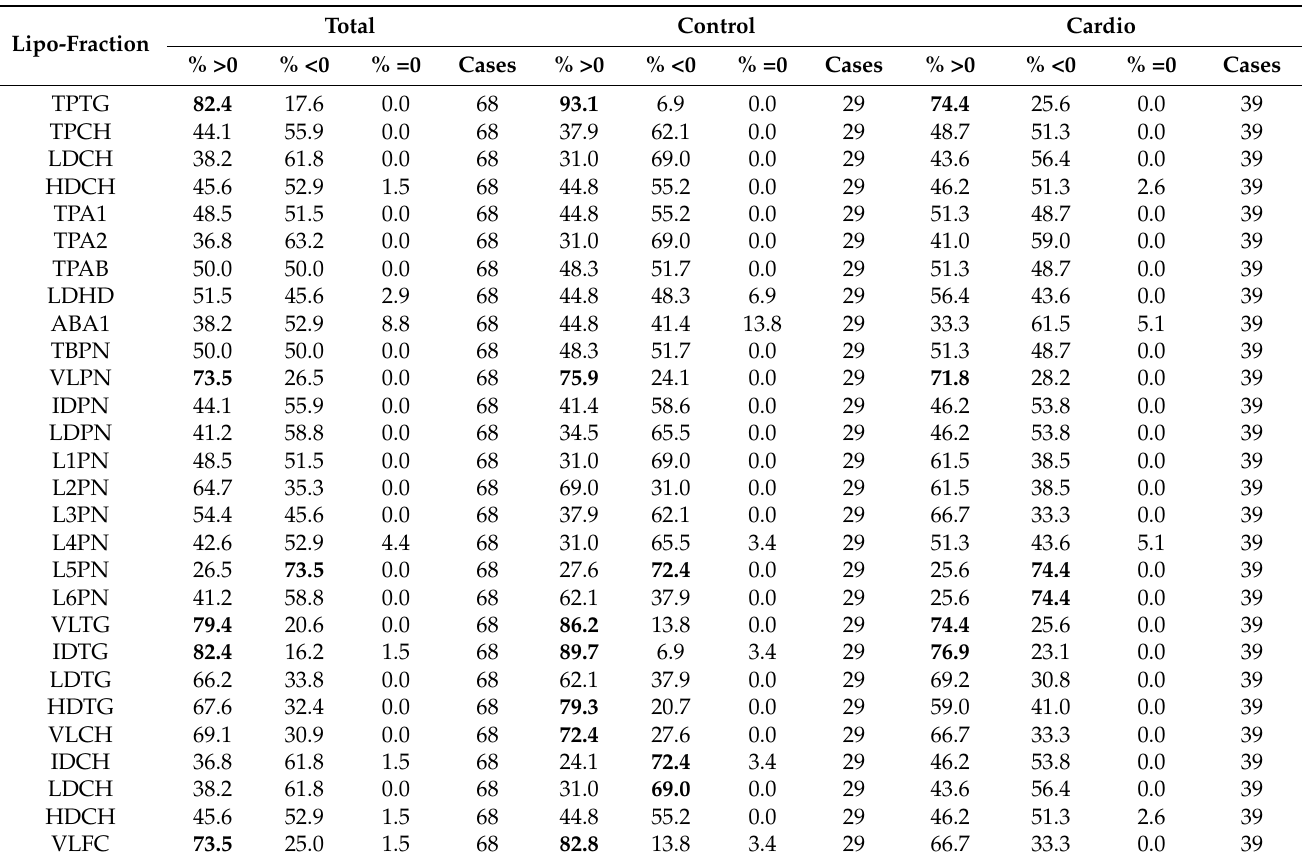
Table 2. Trends for lipoprotein evolution after food intake. Significant changes (marked in bold) are considered when more than 70% of cases exhibit the same